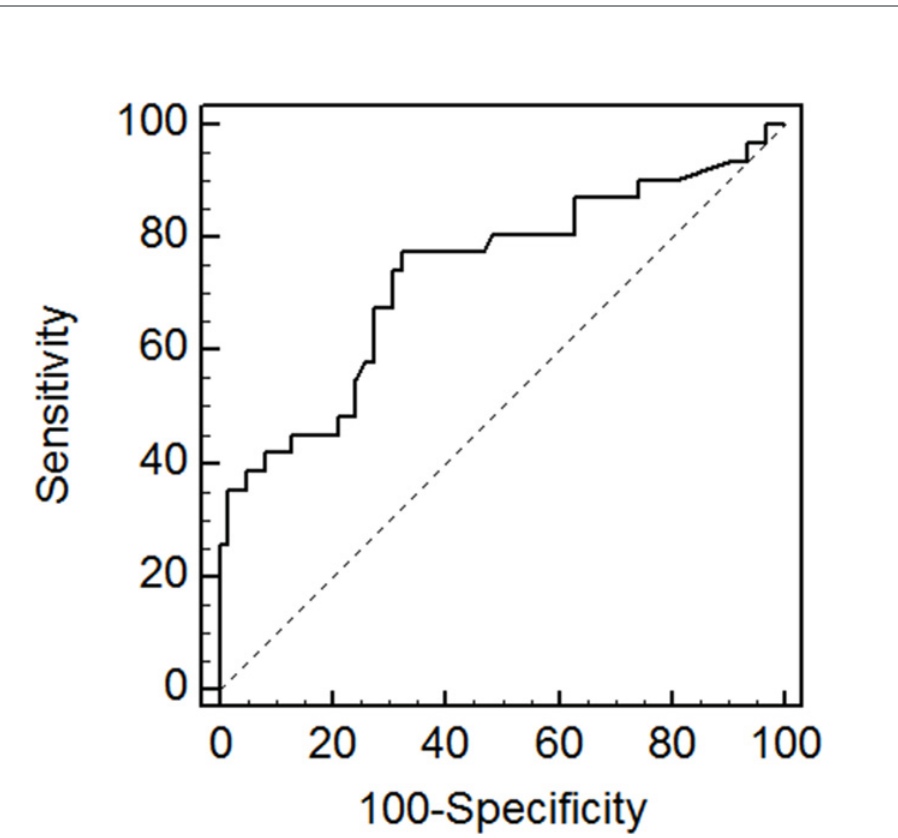
Fig 2. Receiver operating curve for change in cervical length in the prediction of emergency cesarean section in women with placenta